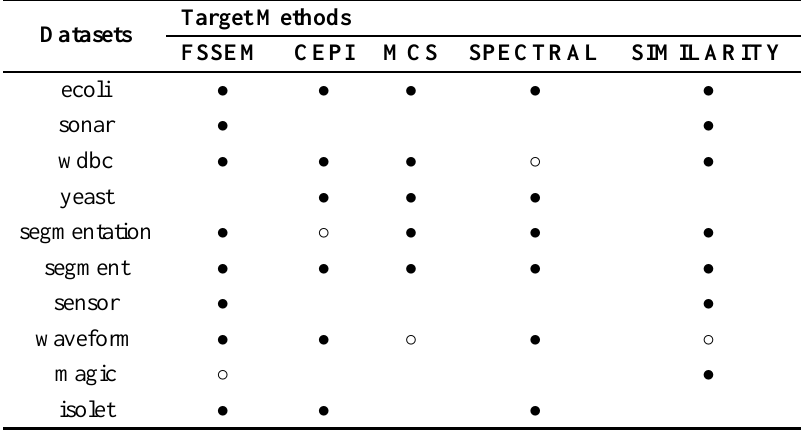
Table 4. Comparisons of our method with state-of-the-art unsupervised feature selection methods by squared errors of SimpleKMeans